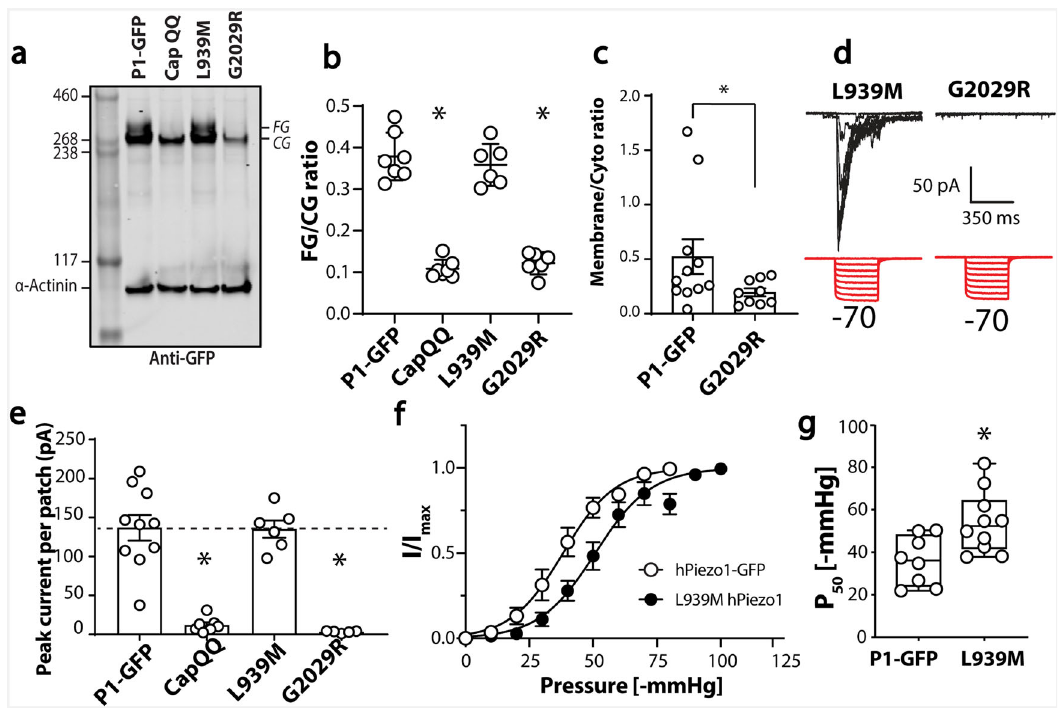
Fig. 7 N-glycosylation status of Piezo1 variants linked to generalised lymphatic dysplasia (GLD). a Representative western blot showing Piezo1 protein, CapQQ (N2294Q/N2331Q) and two GLD associated mutations (L939M and G2029R). b Relative quanti fi cation of intensity of upper band (FG) over lower band (CG) for Piezo1, CapQQ, L939M and G2029R. c Membrane to cytoplasmic ratio of immunogold of G2029R compared to human Piezo1. d Electrophysiological recordings of Piezo1 − / − HEK293T expressing L939M and G2029R in the cell attached con fi guration in response to negative pressure applied using a high-speed pressure-clamp (red). e Quanti fi cation of peak current elicited per patch for point mutations shown in d compared to current from Piezo1-GFP and CapQQ mutant. f Pressure response curve for Piezo1-GFP against L939M expressed in Piezo1 − / − HEK293T. g Minimum to maximum box and whiskers plot showing the average P 50 [-mmHg] of Piezo1-GFP and L939M